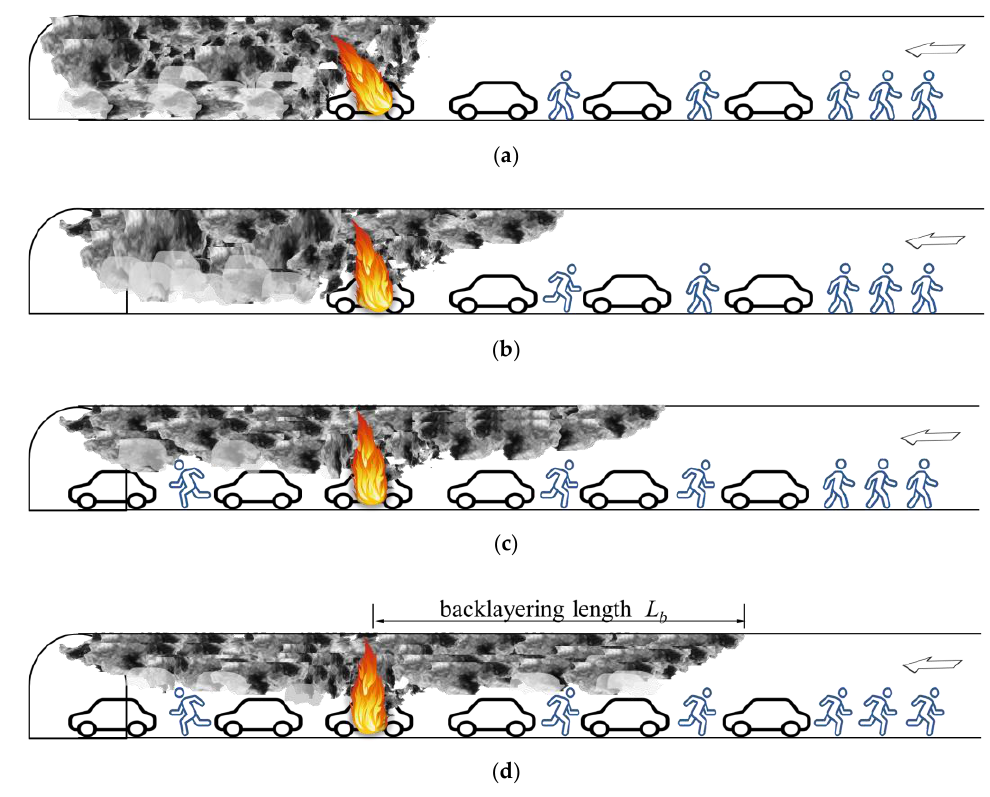
Figure 1. Longitudinal ventilation systems used in tunnels: ( a ) No traffic jam before the fire ( U m = 3 m/s); ( b ) No traffic jam before the fire ( U m = 2 m/s); ( c ) Traffic jam before the fire ( U m = 1 m/s); ( d ) Traffic jam before the fire ( U m = 0 m/s).